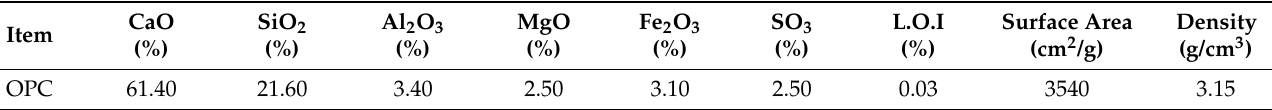
Table 1. Chemical composition and physical properties of ordinary Portland cement.